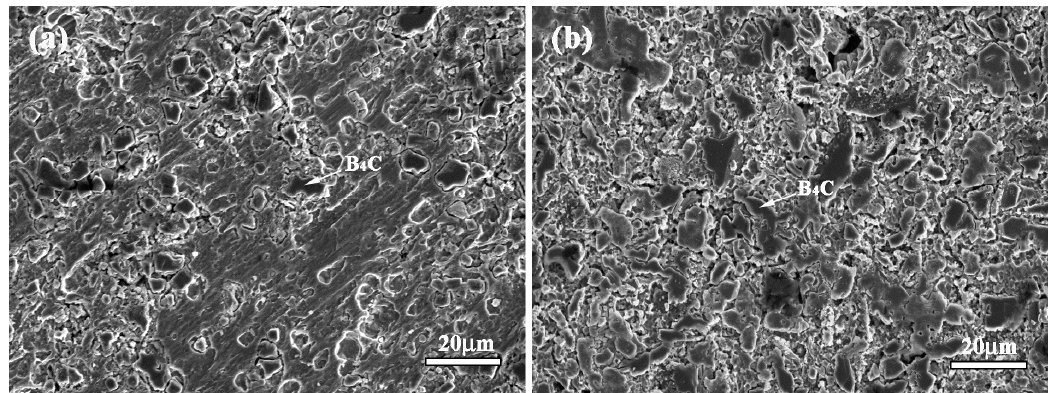
Figure 2. Metallography of B 4 C/Al 5083 composite with ( a ) 10 wt % B 4 C content and ( b ) 30 wt % B 4 C content.